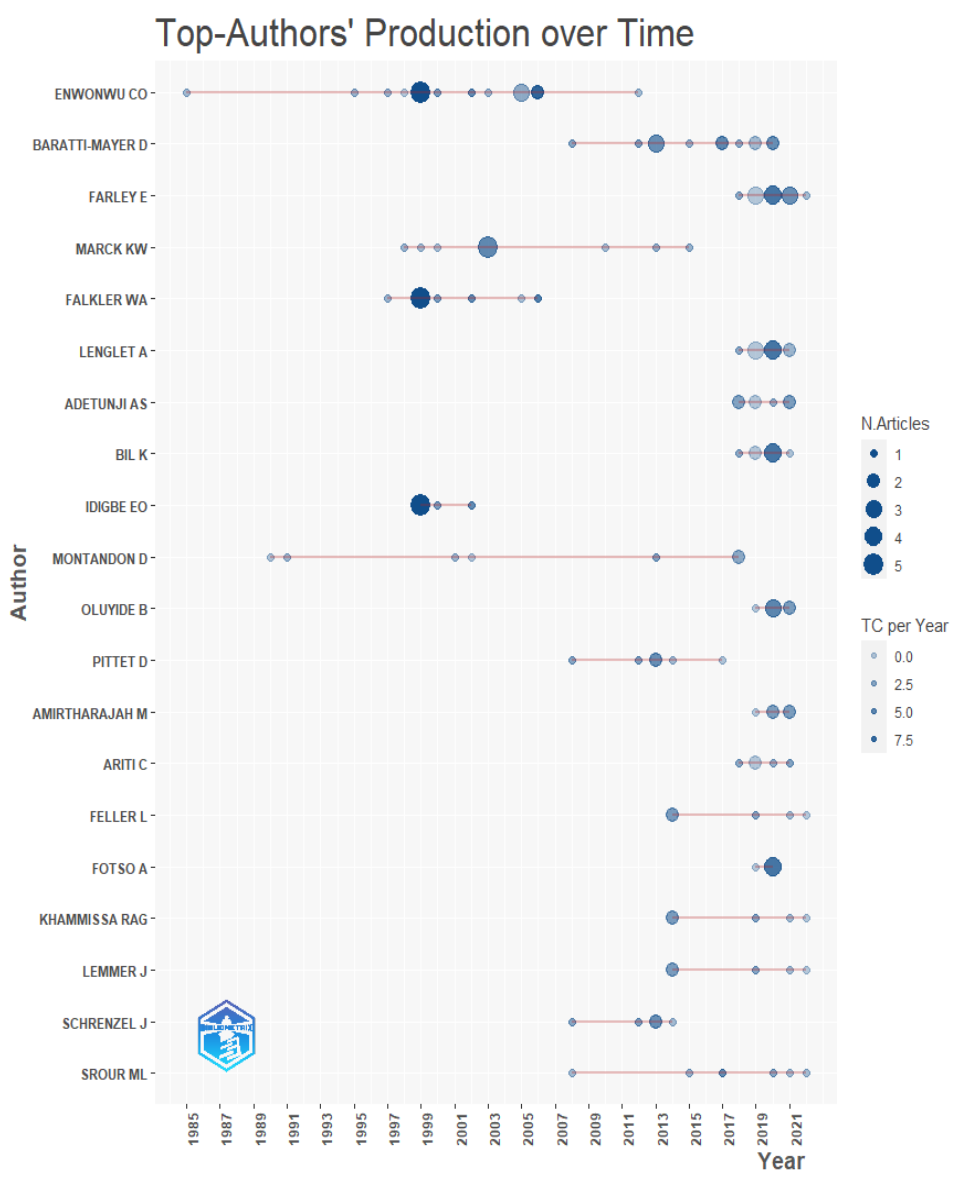
Figure 2. Scientific production of the top authors over time. TC: total citations .